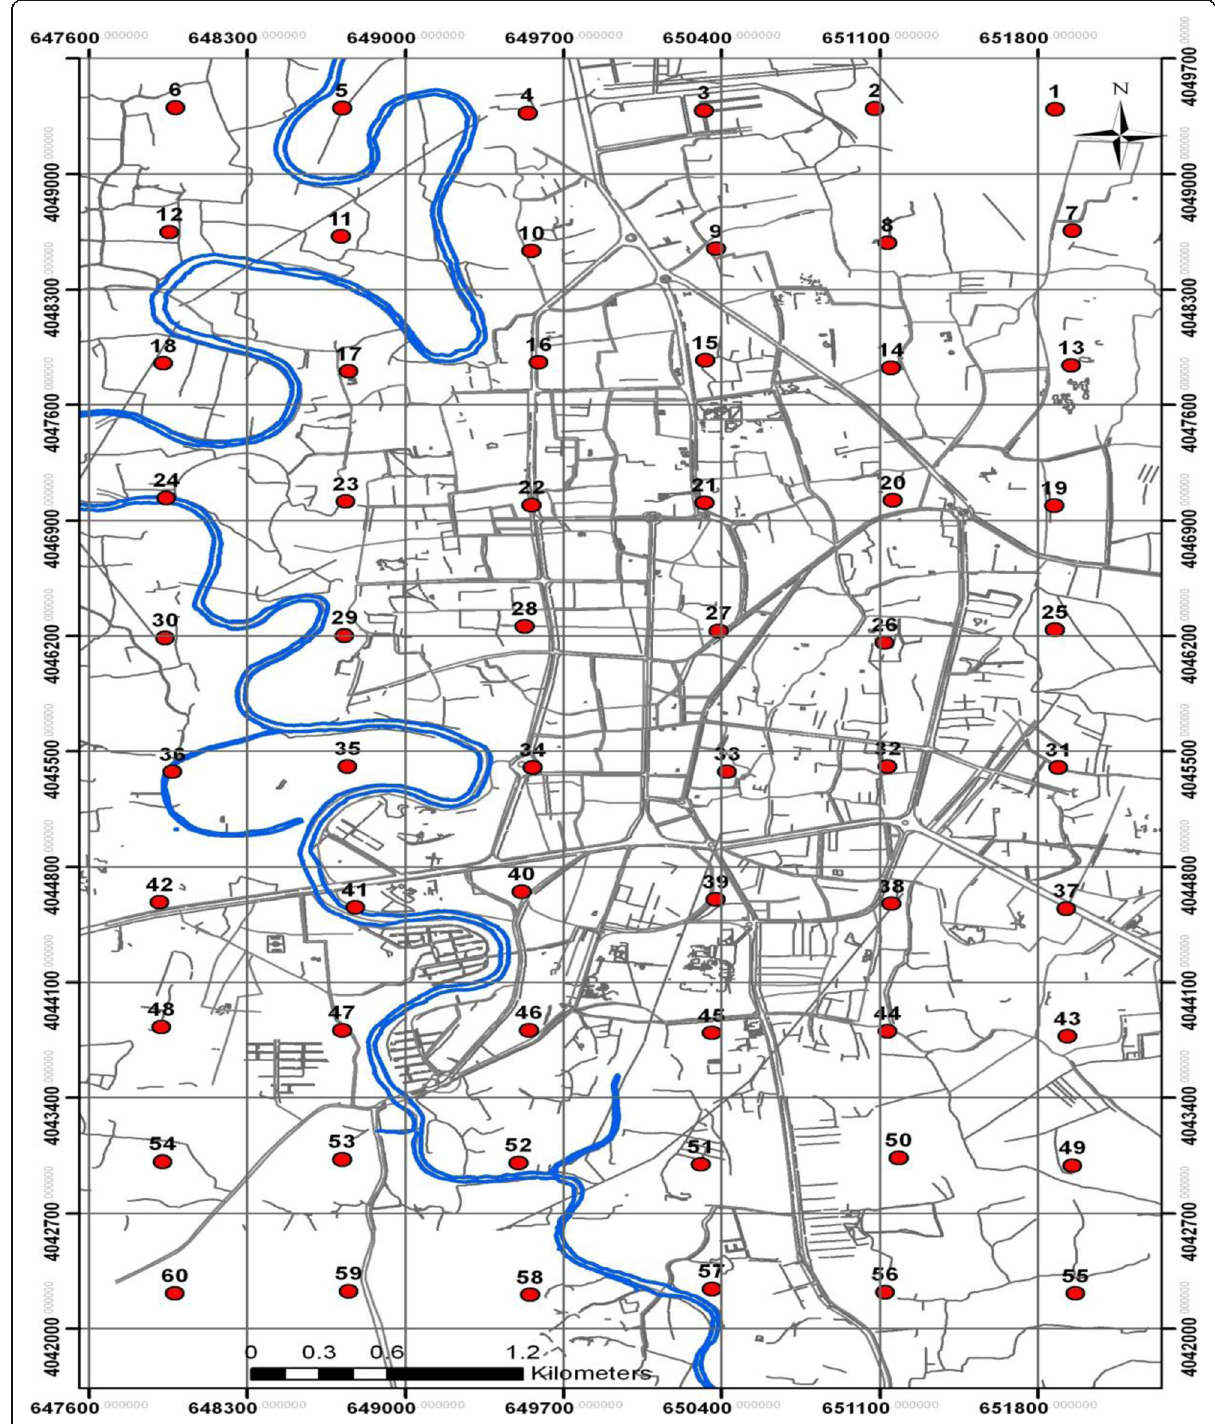
Fig. 1 Location of some boreholes in Babol The values of CSR calculated using Eq. (1) pertain to the equivalent uniform shear stress induced by the earthquake ground motions generated by an earthquake having a moment magnitude M. It has been customary